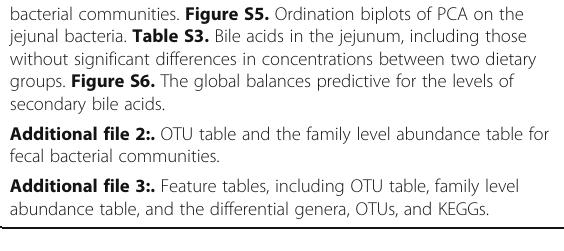
bacterial communities. Figure S5. Ordination biplots of PCA on the jejunal bacteria. Table S3. Bile acids in the jejunum, including those without significant differences in concentrations between two dietary groups. Figure S6. The global balances predictive for the levels of secondary bile acids. Additional file 2:. OTU table and the family level abundance table for fecal bacterial communities. Additional file 3:. Feature tables, including OTU table, family level abundance table, and the differential genera, OTUs, and